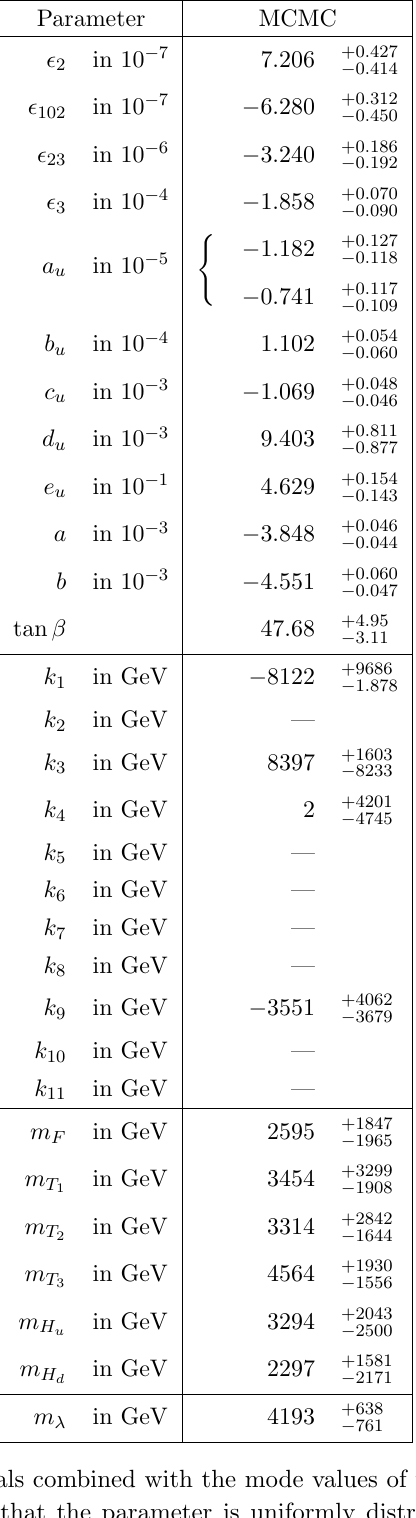
= ( Y u ) 22 j , where ( Y u ) 11 = a u 12